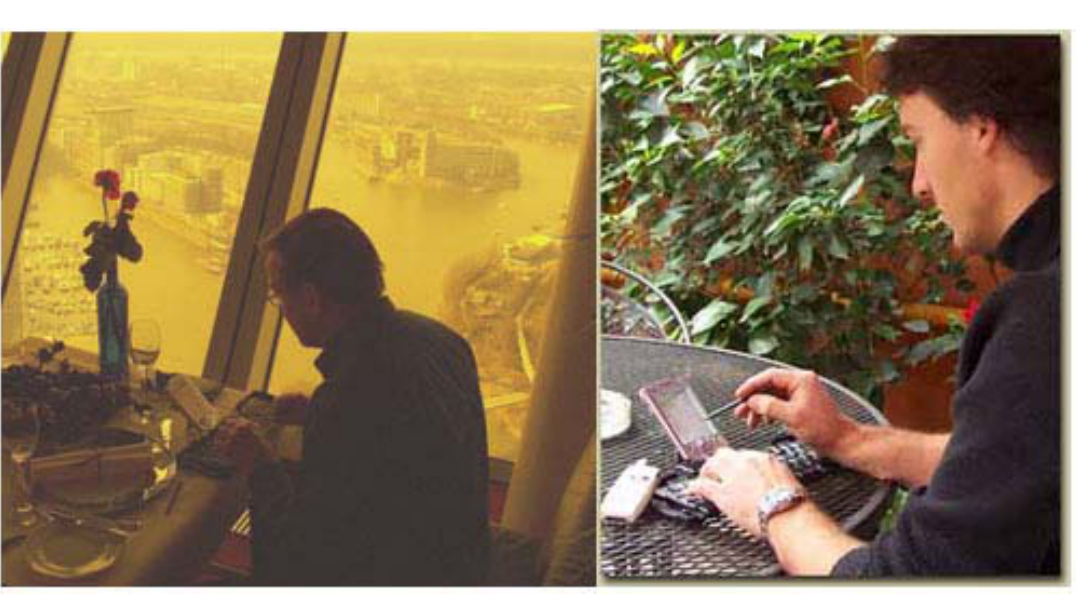
Figure 2. The picture on the left shows a tutor 'on the move,' writing and sending emails to his students from Düsseldorf ‘Himmelturm.’ The next picture is of a student on holiday communicating from the garden of his hotel in